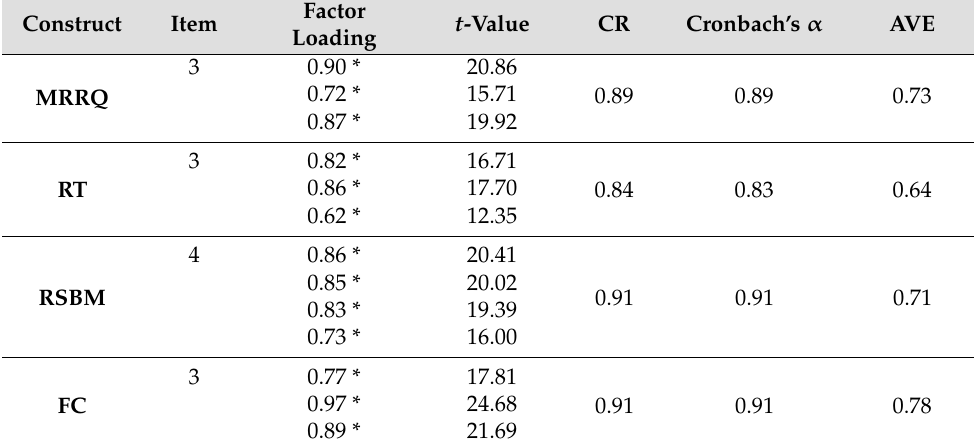
Table 5. Measurement